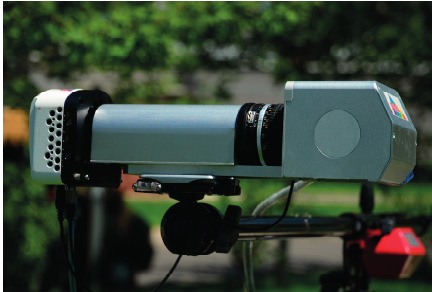
Figure 1. Photograph of the field imaging spectroscopy system (FISS) components.